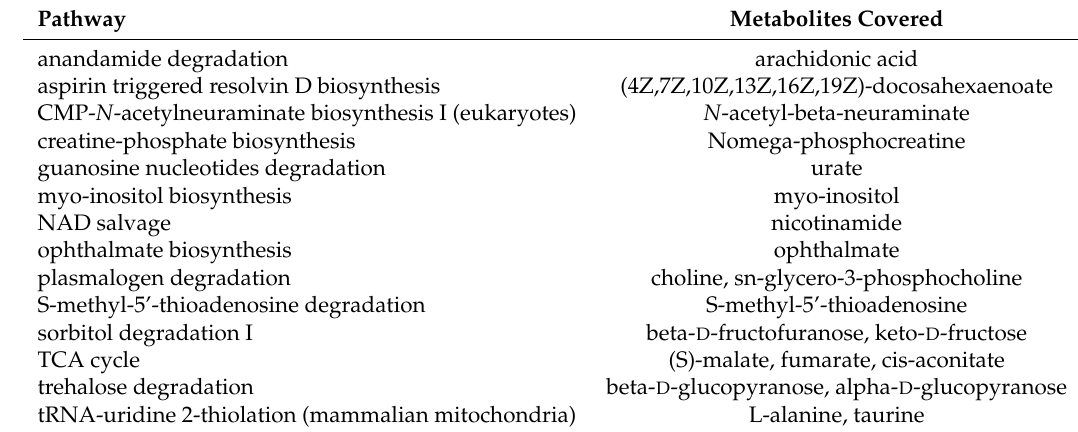
Table A6. ST000741, Pathway Covering Using Pathway Size Cost